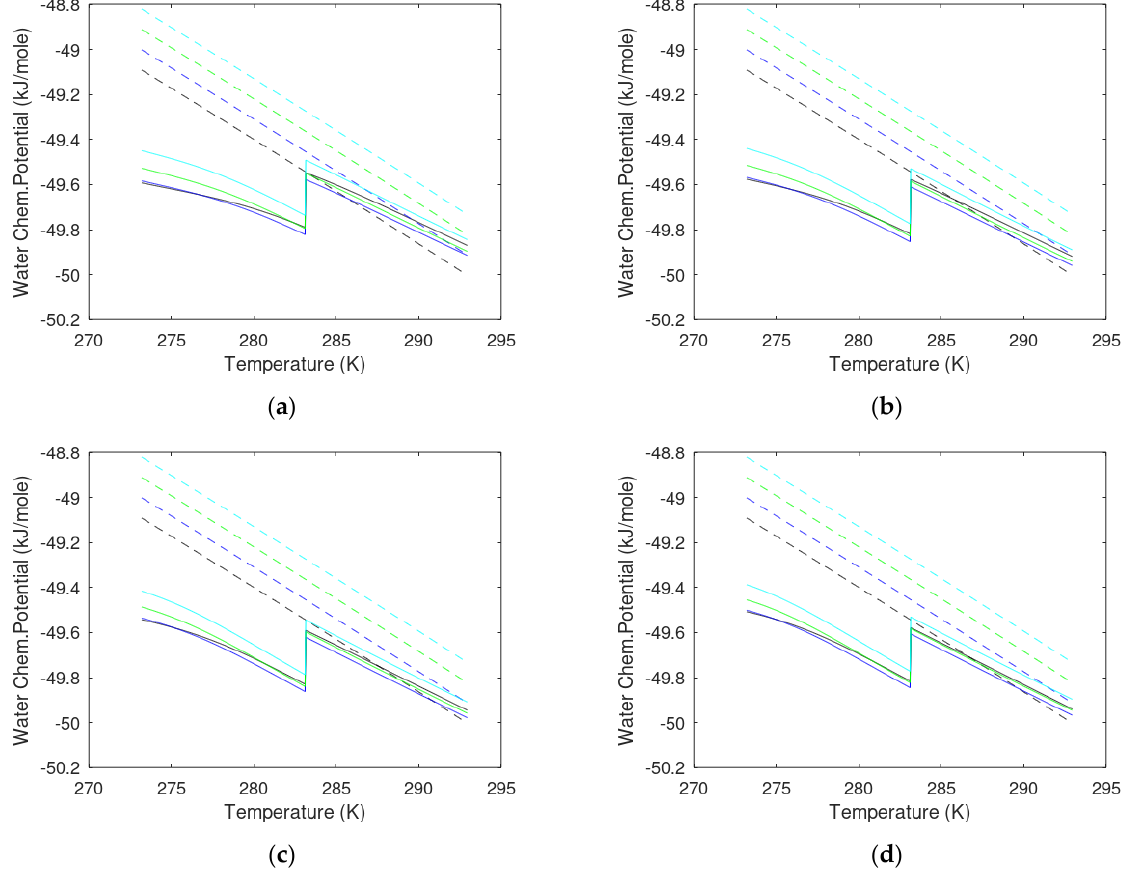
Figure 7. ( a ) Liquid water chemical potential (dashed) and hydrate water chemical potential (solid) for four different pressures and a CO 2 /N 2 mixture containing 95 mole% CO 2 . Black curve is for 100 bar pressure, blue is for 150 bar pressure, green is for 200 bar pressure, and cyan is for 250 bar pressure. ( b ) Same as (a) but for 90 mole% CO 2 . ( c ) Same as (a) but for 80 mole% CO 2 . ( d ) Same as (a) but for 70 mole% CO 2 .